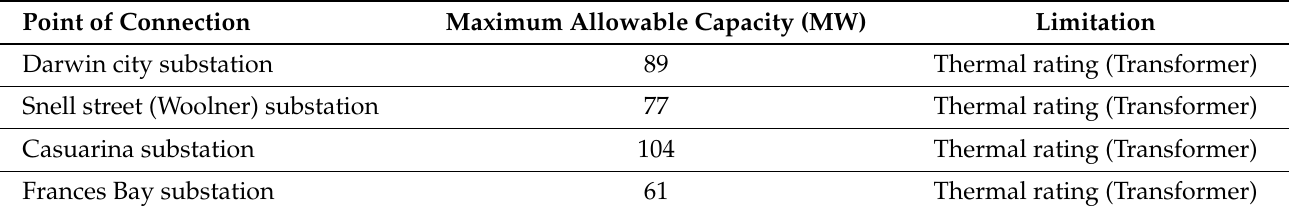
Table 2. Locational tidal HC at different locations in DKIS.